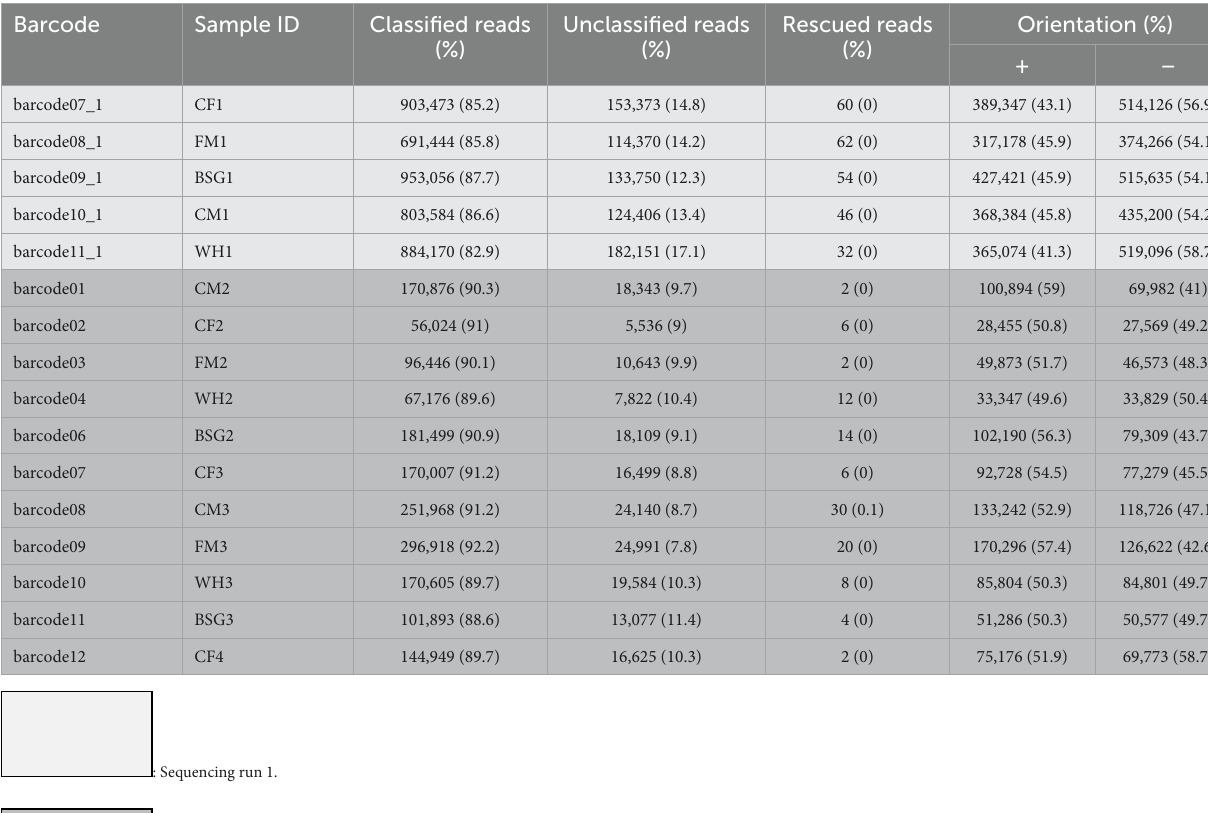
TABLE 1 Classification of reads and orientation statistics of black soldier fly larvae reared on various diets after sequencing. Barcode Sample